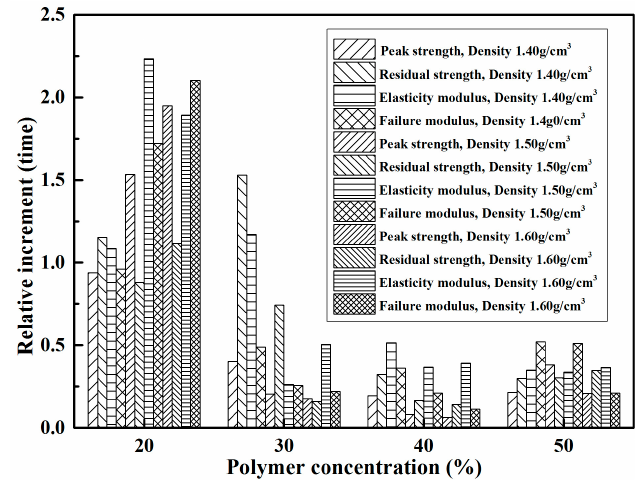
Figure 7. The variation of relative increment of peak strength, residual strength, elasticity modulus, and failure modulus.